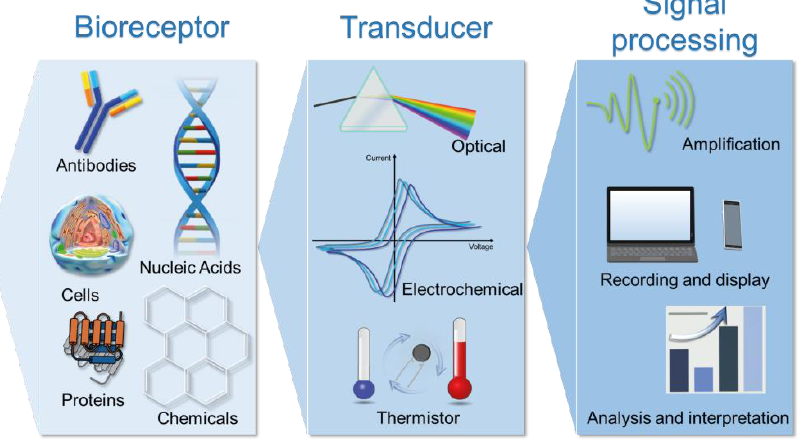
Figure 2. Schematic representation of biosensor design.